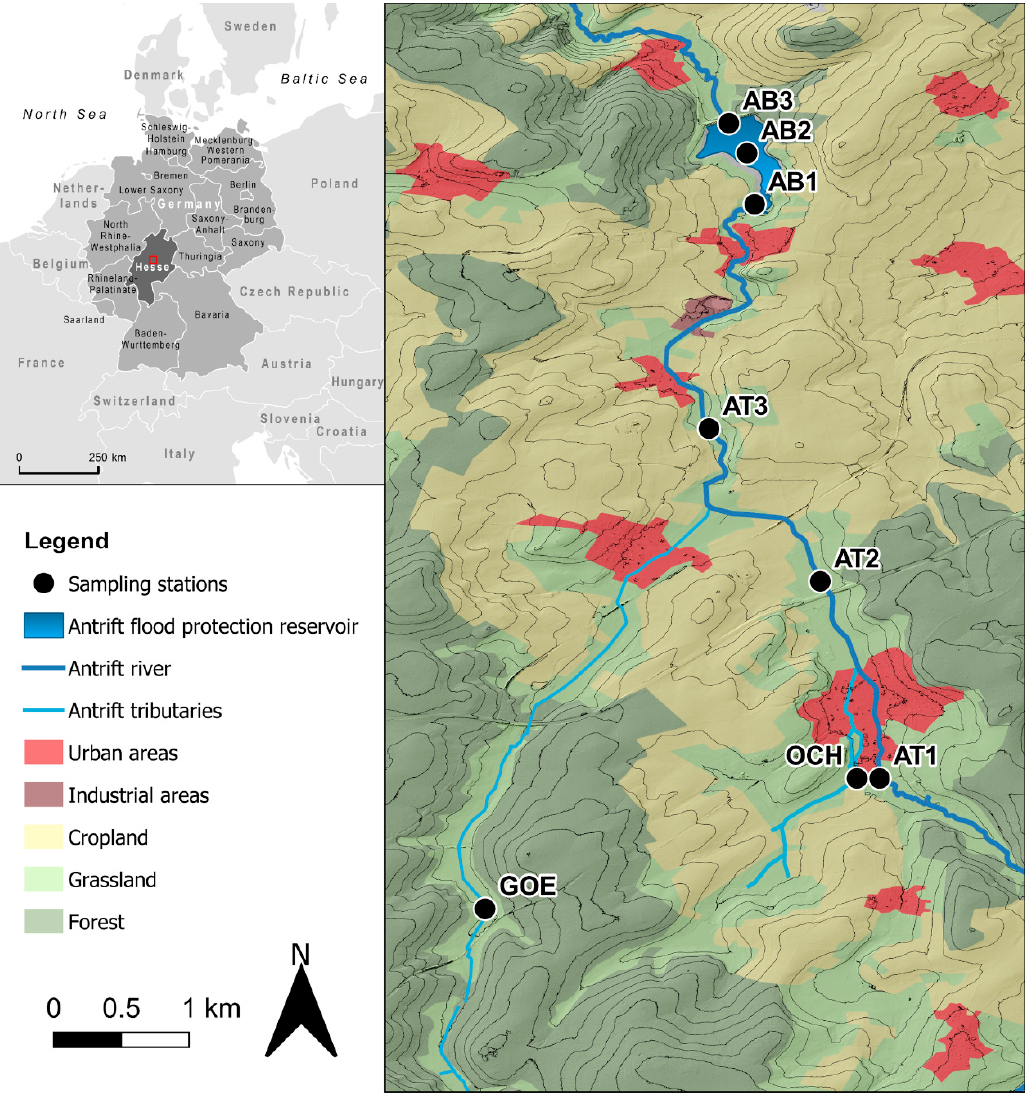
Figure 1. Location of the Antrift catchment with main water courses and sampling/measurement stations. (Data source: CORINE land use classification by Umweltbundesamt, 2019, DEM 1 m by Hessian Administration for Soil Management and Geoinformation, and overview map according to Weihrauch et al. 2020).